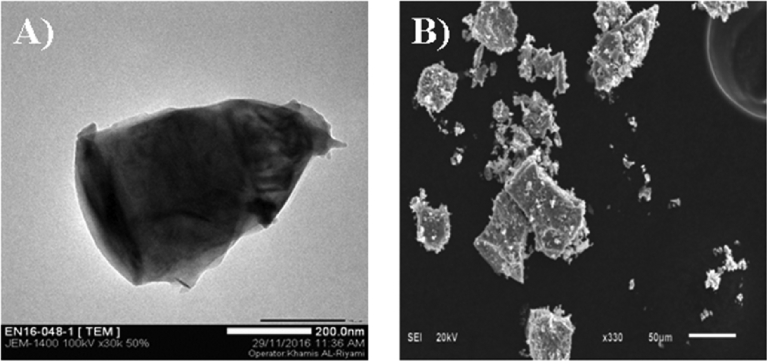
A TEM image of V2O5 neat, B SEM image of V2O5 neat both of them synthesized at 500 °C and pH 2.5.